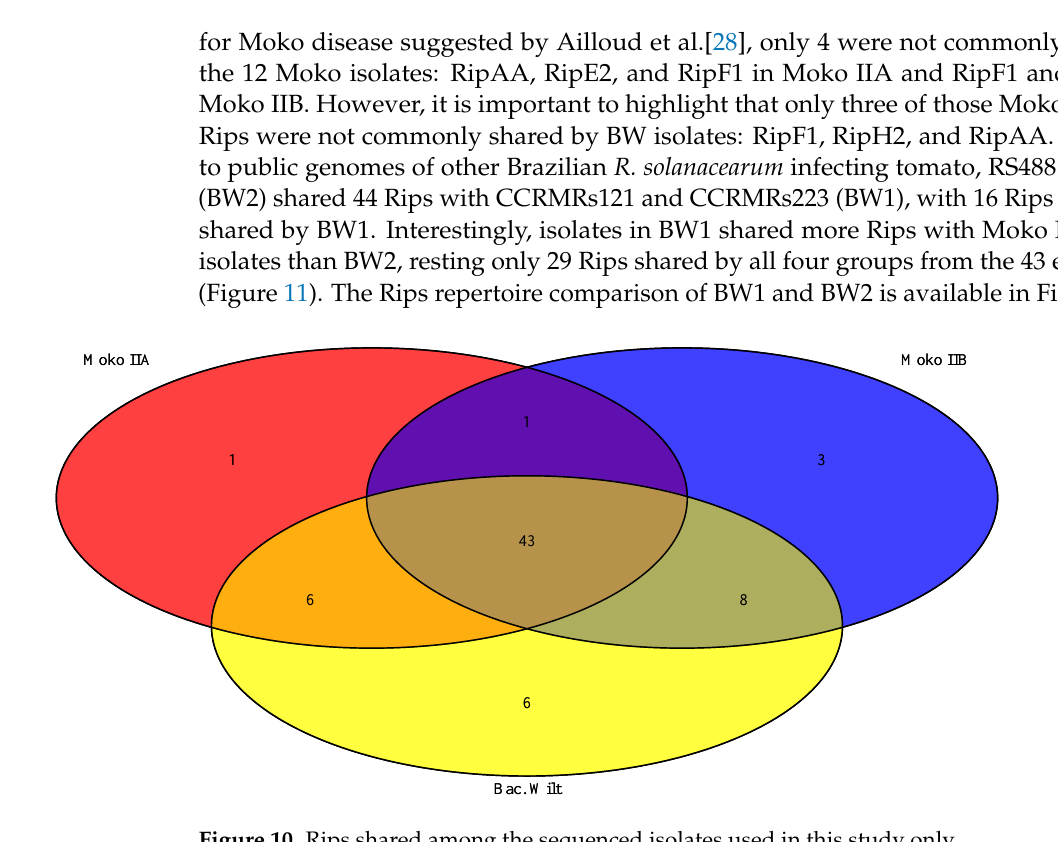
Figure 10. Rips shared among the sequenced isolates used in this study only.